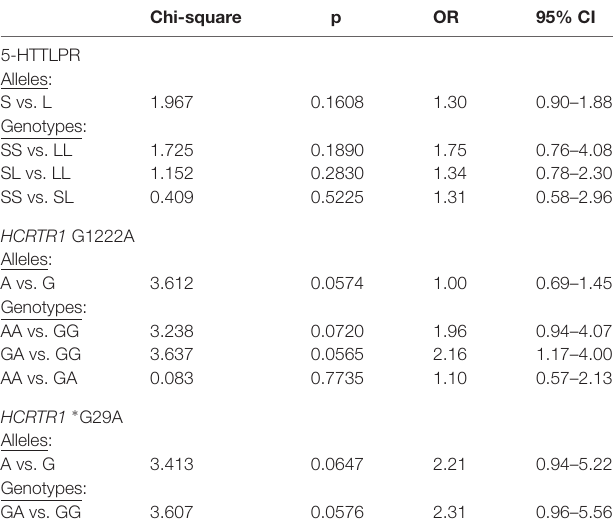
TABLE 3 | Genotypic and allelic distribution of 5-HTTLPR and HCRTR1 G1222A, ∗ G29A polymorphisms in migraine patients (MA+MO) compare to control subjects.